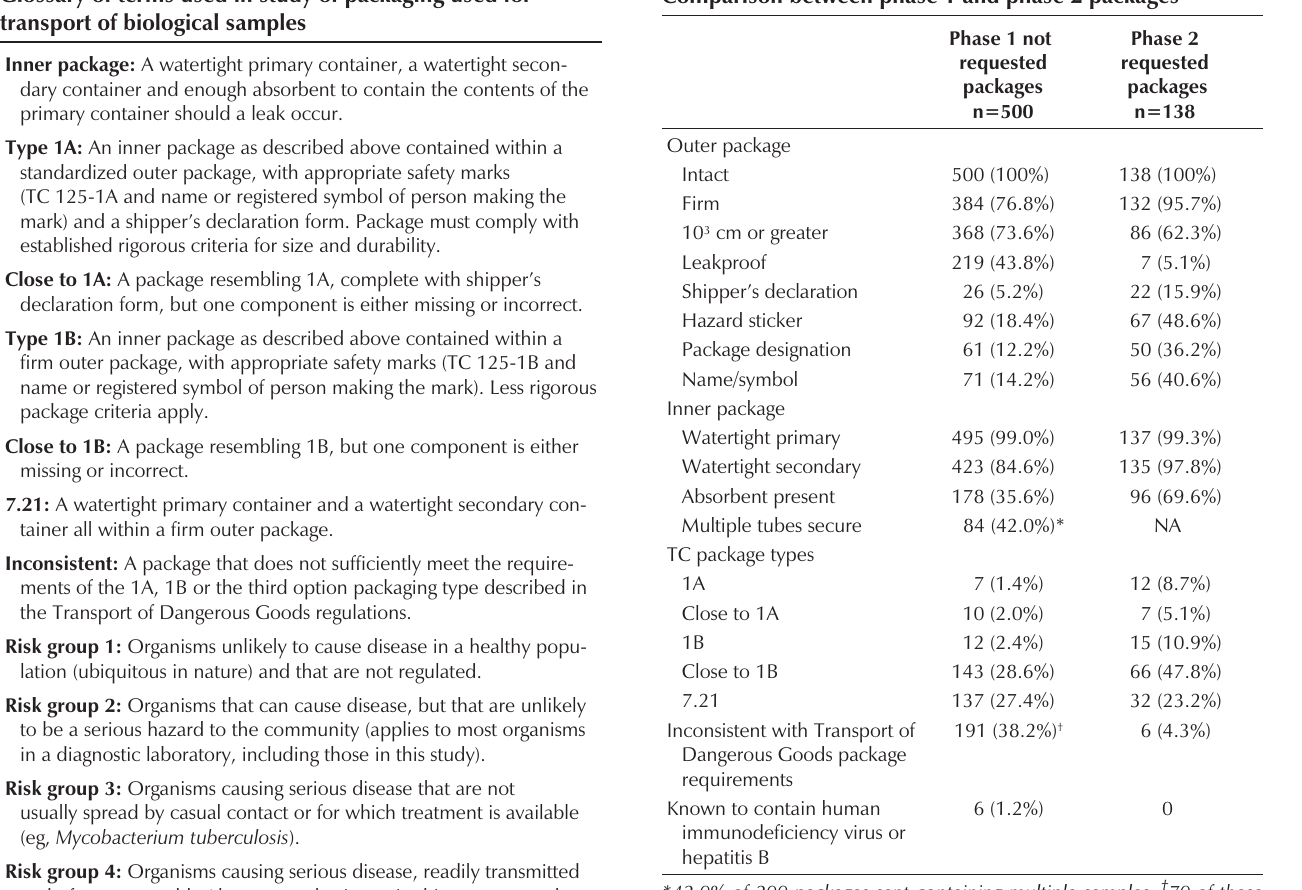
Comparison between phase 1 and phase 2